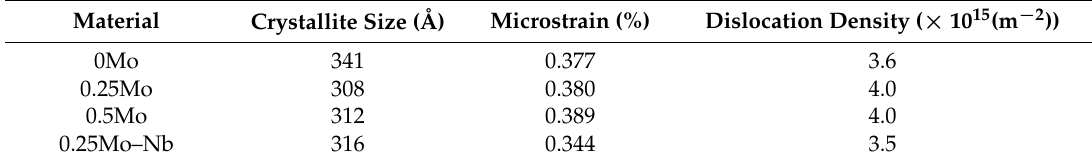
Figure 9. Correlation of the 28 J transition temperatures and the yield strength: ( a ) FRT 800 °C and ( b ) FRT 900 °C.